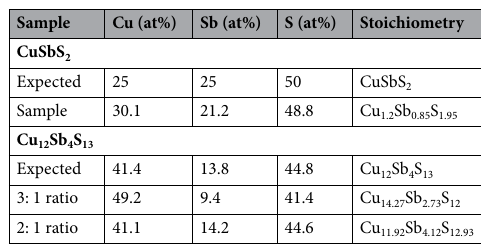
Table 1. The content of Cu, Sb and S, in chalcostibite (CuSbS 2 ) and tetrahedrite (Cu 12 Sb 4 S 13 ) samples calculated from theoretical values and those found experimentally by EDX spectroscopy.